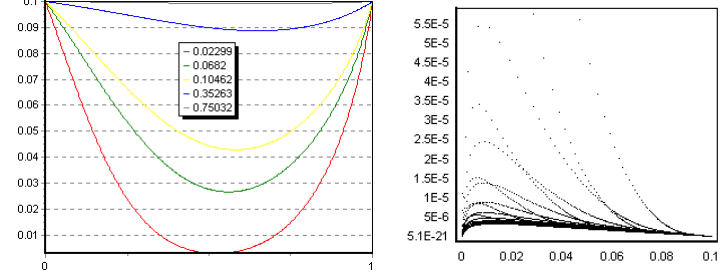
Figure(cid:2)(cid:1)Totalphasediagram